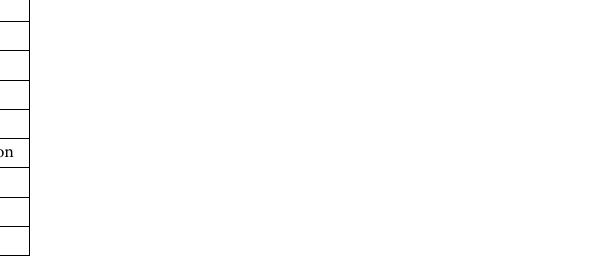
Table 1. Engine specifications.